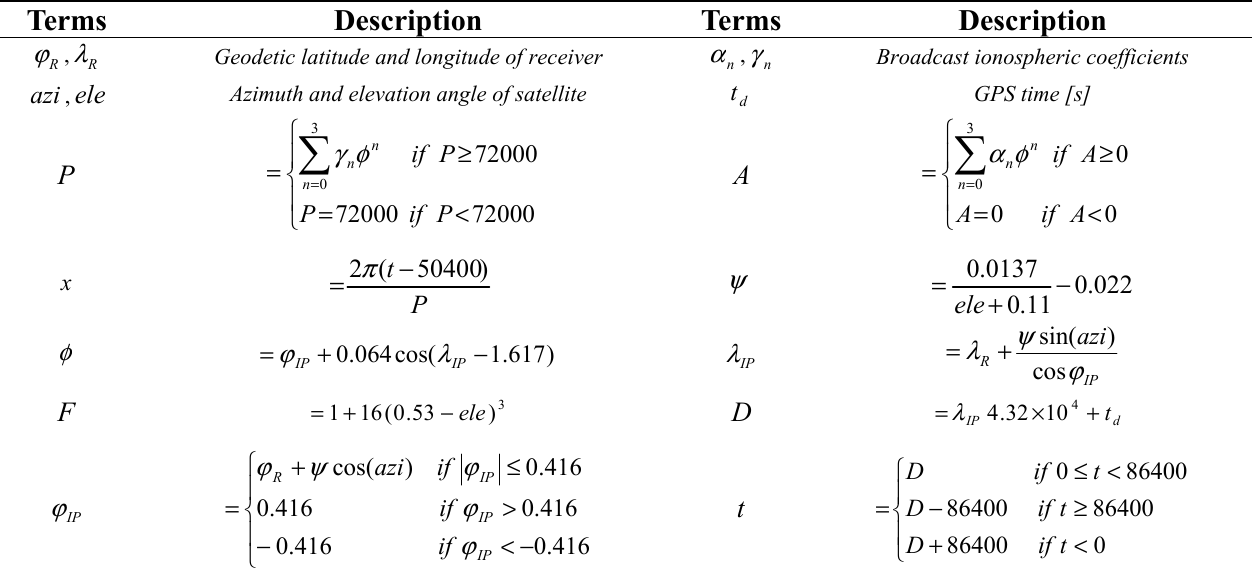
Table 1. Descriptions of abbreviations used in Klobuchar model